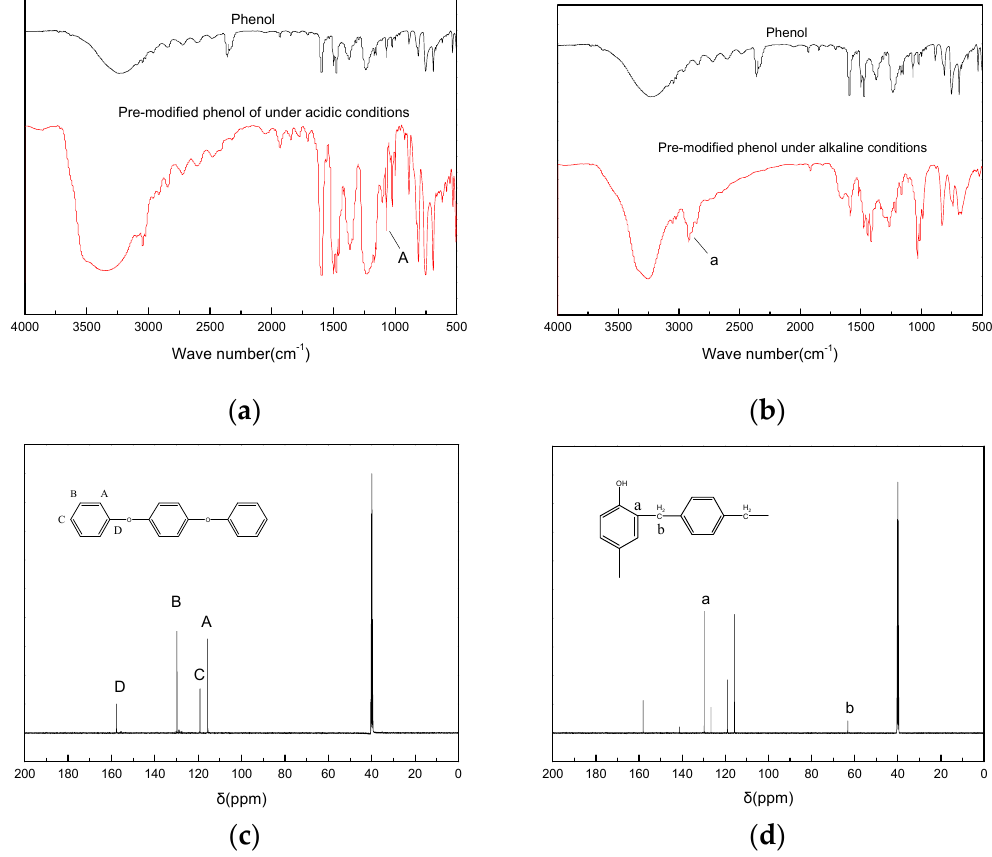
Figure 1. ( a ) FTIR spectra of terephthalyl-alcohol-modified phenol under acidic conditions; ( b ) FTIR spectra of terephthalyl-alcohol-modified phenol under basic conditions; ( c ) 13 C HMR spectrum terephthalyl-alcohol-modified phenol under acidic conditions; ( d ) 13 C HMR spectrum of terephthalyl-alcohol-modified phenol under basic conditions.